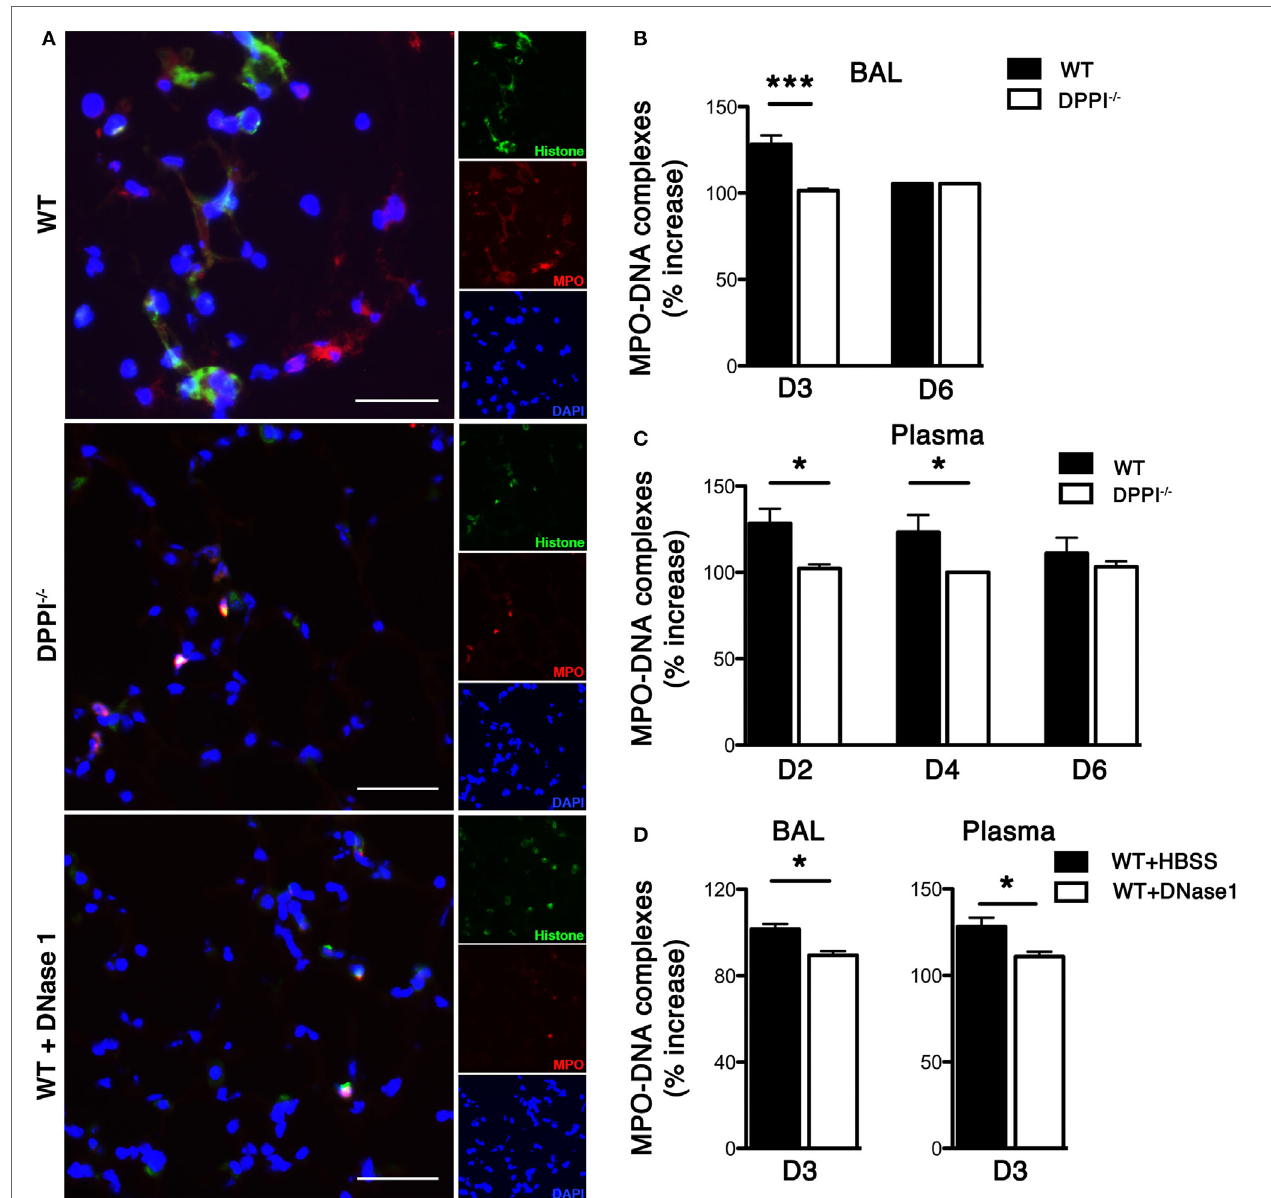
FigUre 1 | sev infection induces pulmonary neTs . WT and DPPI − / − mice were infected with Sev and their blood, lung, and BALF harvested on the indicated day PI. (a) Frozen lung sections from day 3 PI were stained for histone (green) and MPO (red). DAPI stained nuclei blue. The absence of DPPI and DNase 1 treatment suppressed NET formation. (B–D) BALF fluid and plasma from Sev-infected animals were collected on the indicated days and assayed for levels of MPO–DNA complexes. Values represent increase over baseline (obtained from uninfected mice) and expressed as mean ± SEM, n = at least five mice per genotype/treatment group. Scale bars = 100 μ m. * P < 0.05, *** P <